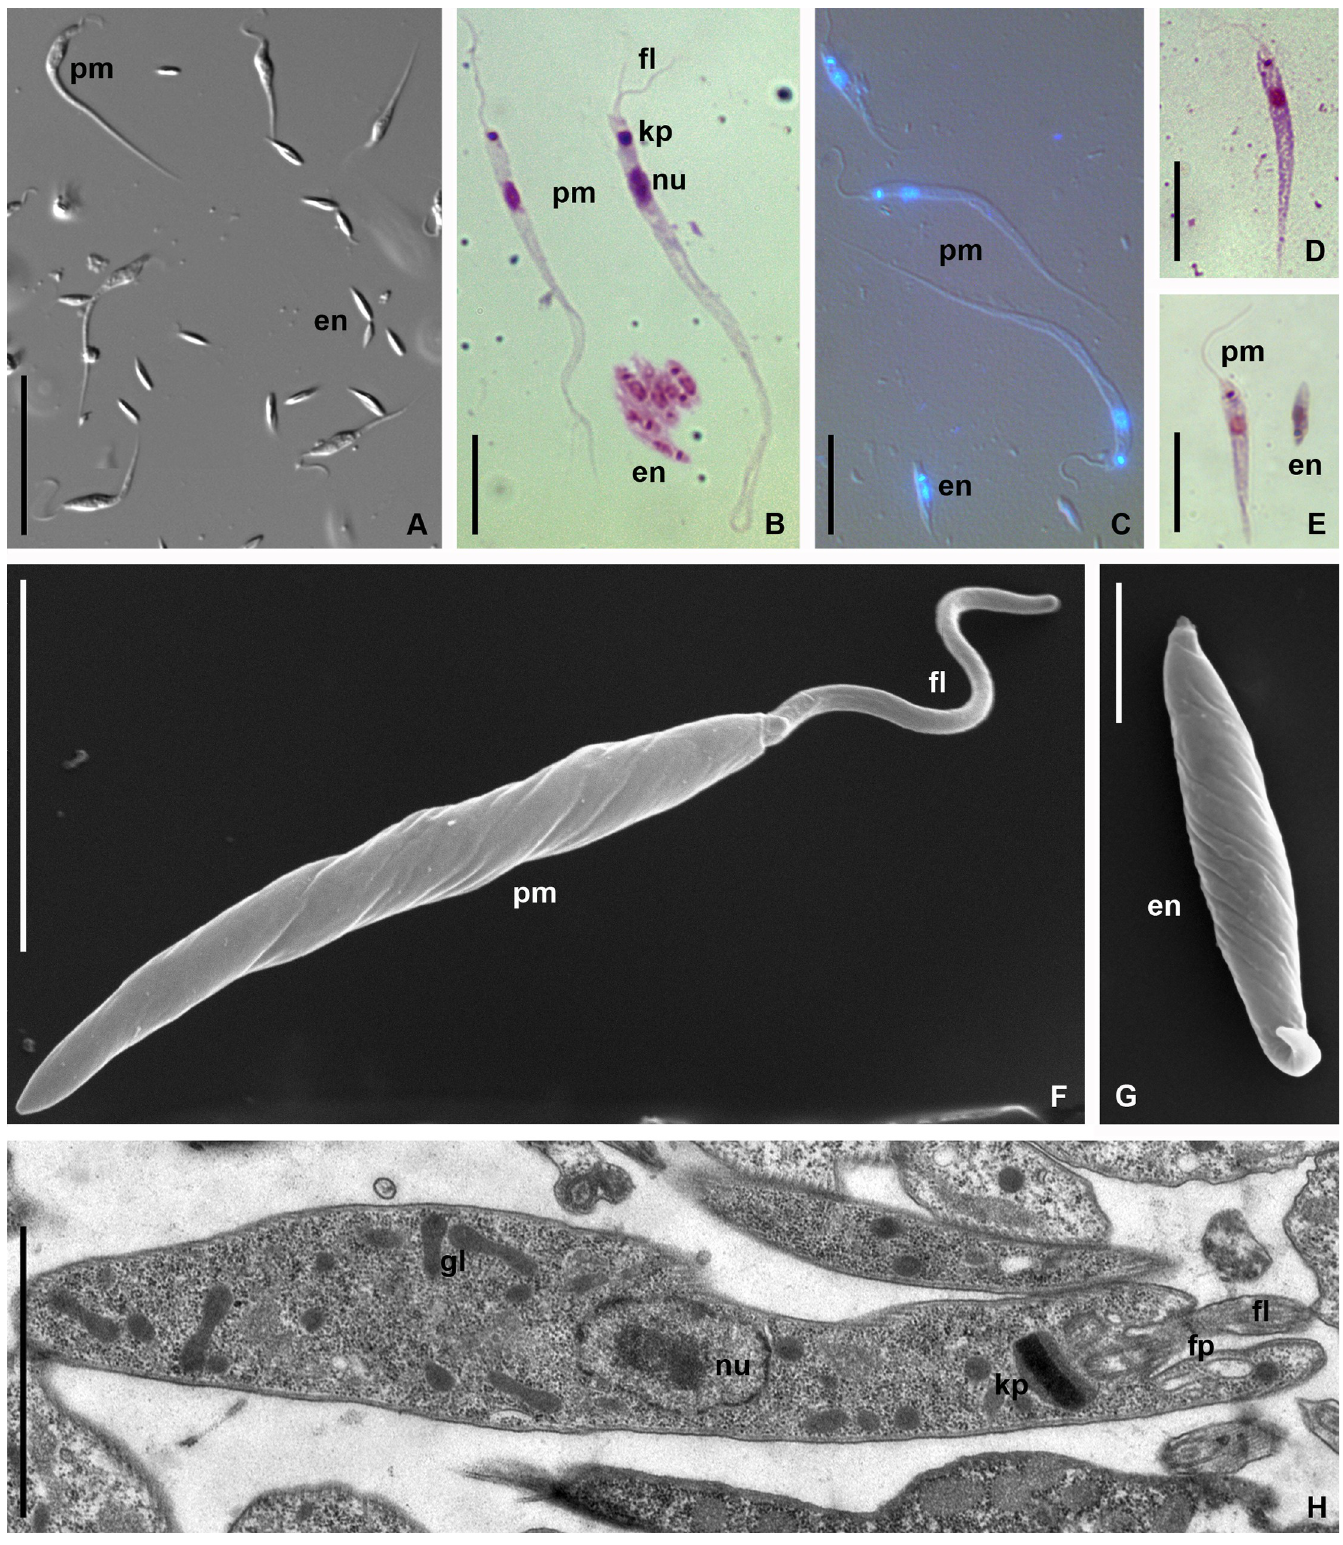
Fig 3. Morphology of Phytomonas lipae (light microscopy, SEM and TEM). A—C . Phytomonas lipae in the salivary gland of C . marginatus ; D. Promastigote of P . lipae from the M1 segment of the host’s midgut; E—H . P . lipae in the axenic culture Cor4. A– ex vivo , DIC; B, D, E– Giemsa; C –overlaid DIC and DAPI; F , G –SEM, H –